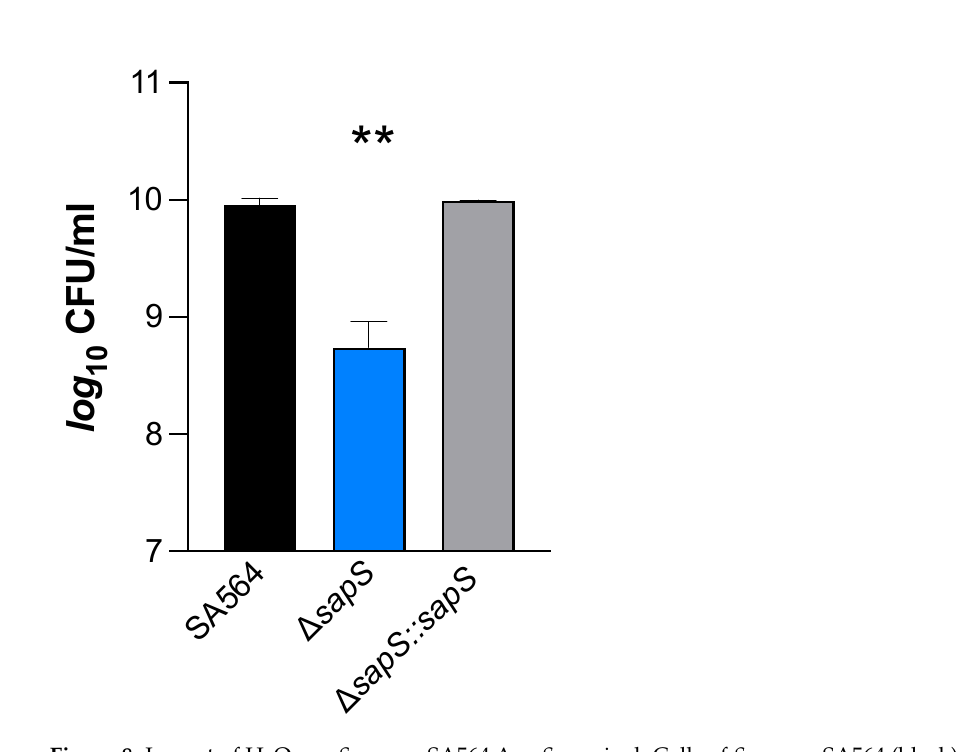
Figure 8. Impact of H 2 O 2 on S. aureus SA564 Δ sapS survival. Cells of S. aureus SA564 (black), SA564 Δ sapS (blue), and SA564 Δ sapS::sapS (grey) were grown in TSB at 37 °C and 225 rpm for 2 h, then were challenged with 50 mM H 2 O 2 , and the CFU counts of the cultures were evaluated at 1 h after the H 2 O 2 challenge. The data displayed are the mean + SD of four biological experiments. **, p < 0.01 (Ordinary One-Way ANOVA test).